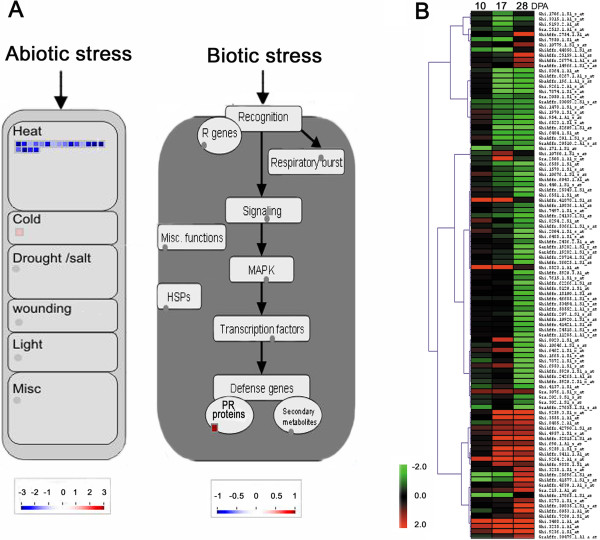
Class 1 involved in stress response in developing fibers of the im mutant. A. MapMan-based visualization of the DEGs involved in abiotic and biotic stress in the im mutant fibers at 10 DPA. Blue and red color squares represent down- and up-regulated genes with a log2 scale, respectively. B. Hierarchical clustering of 103 DEGs identified as stimulus responsive genes by PAGE analysis in the im mutant fibers at 28 DPA. The detailed annotation data and the magnified heatmap are described at the Additional file
3.